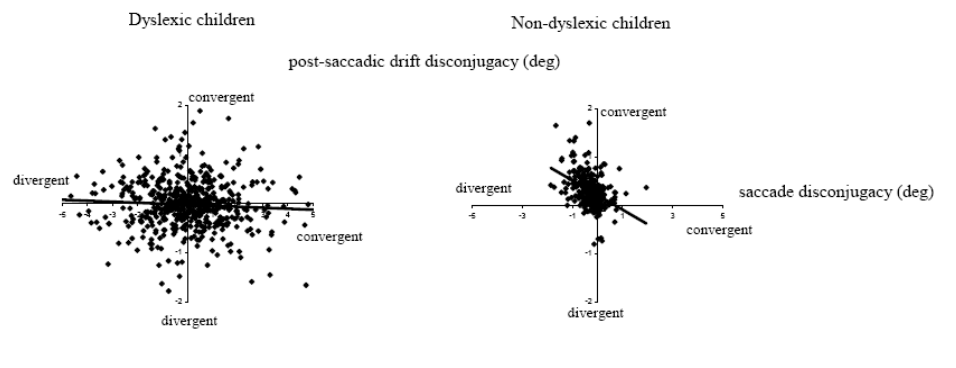
Figure 9. Relationship between saccade and drift disconjugacy. For each saccade in the free exploration condition, the discon- jugacy of the saccade (X-axis) and the disconjugacy of the post-saccadic drift (Y-axis) is shown in degrees. Positive values indicate convergent disconjugacy, negative values divergent